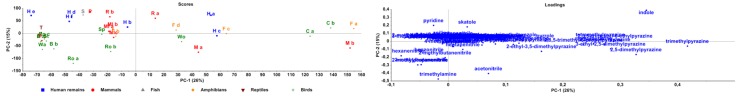
PCA plots of nitrogen-containing compounds.Score- and loadingplot of nitrogen-containing compounds after six months of decomposition.